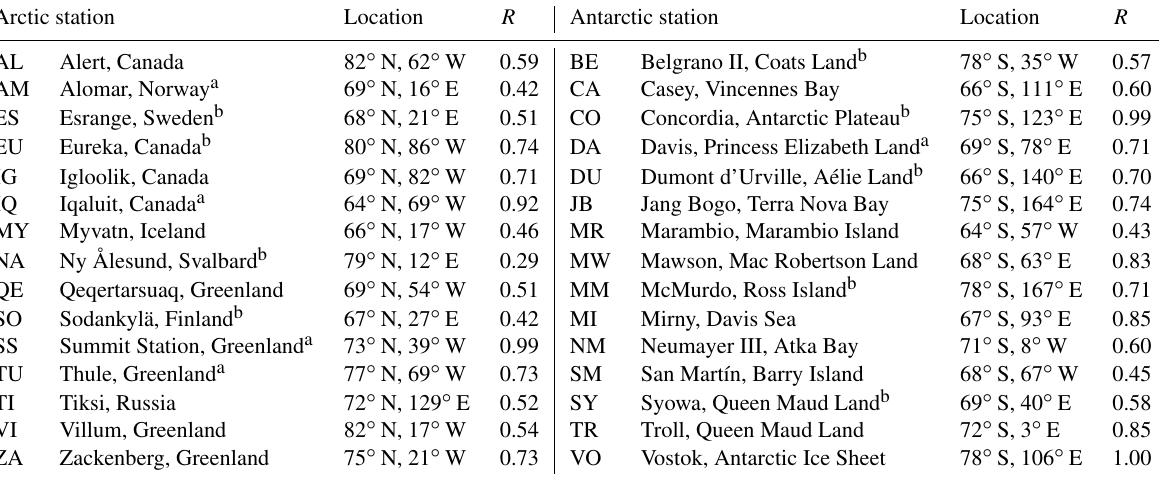
a Stations with a deployment of atmospheric lidar instruments. b Stations with existing PSC data sets.